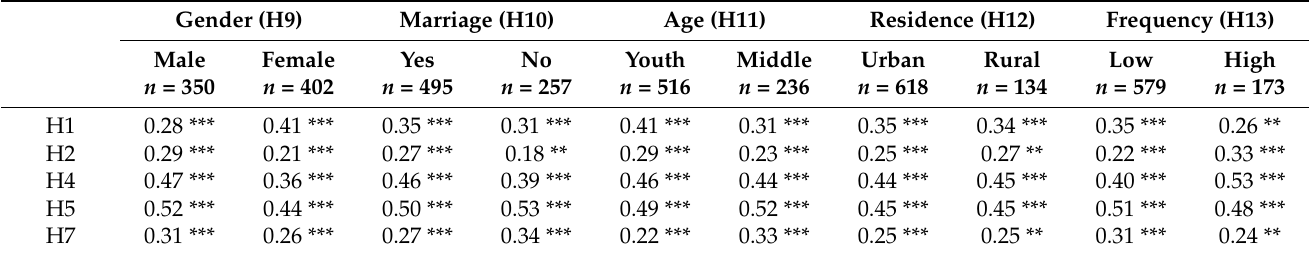
Table 7. Table of estimated parameters for grouping tests of different regulatory